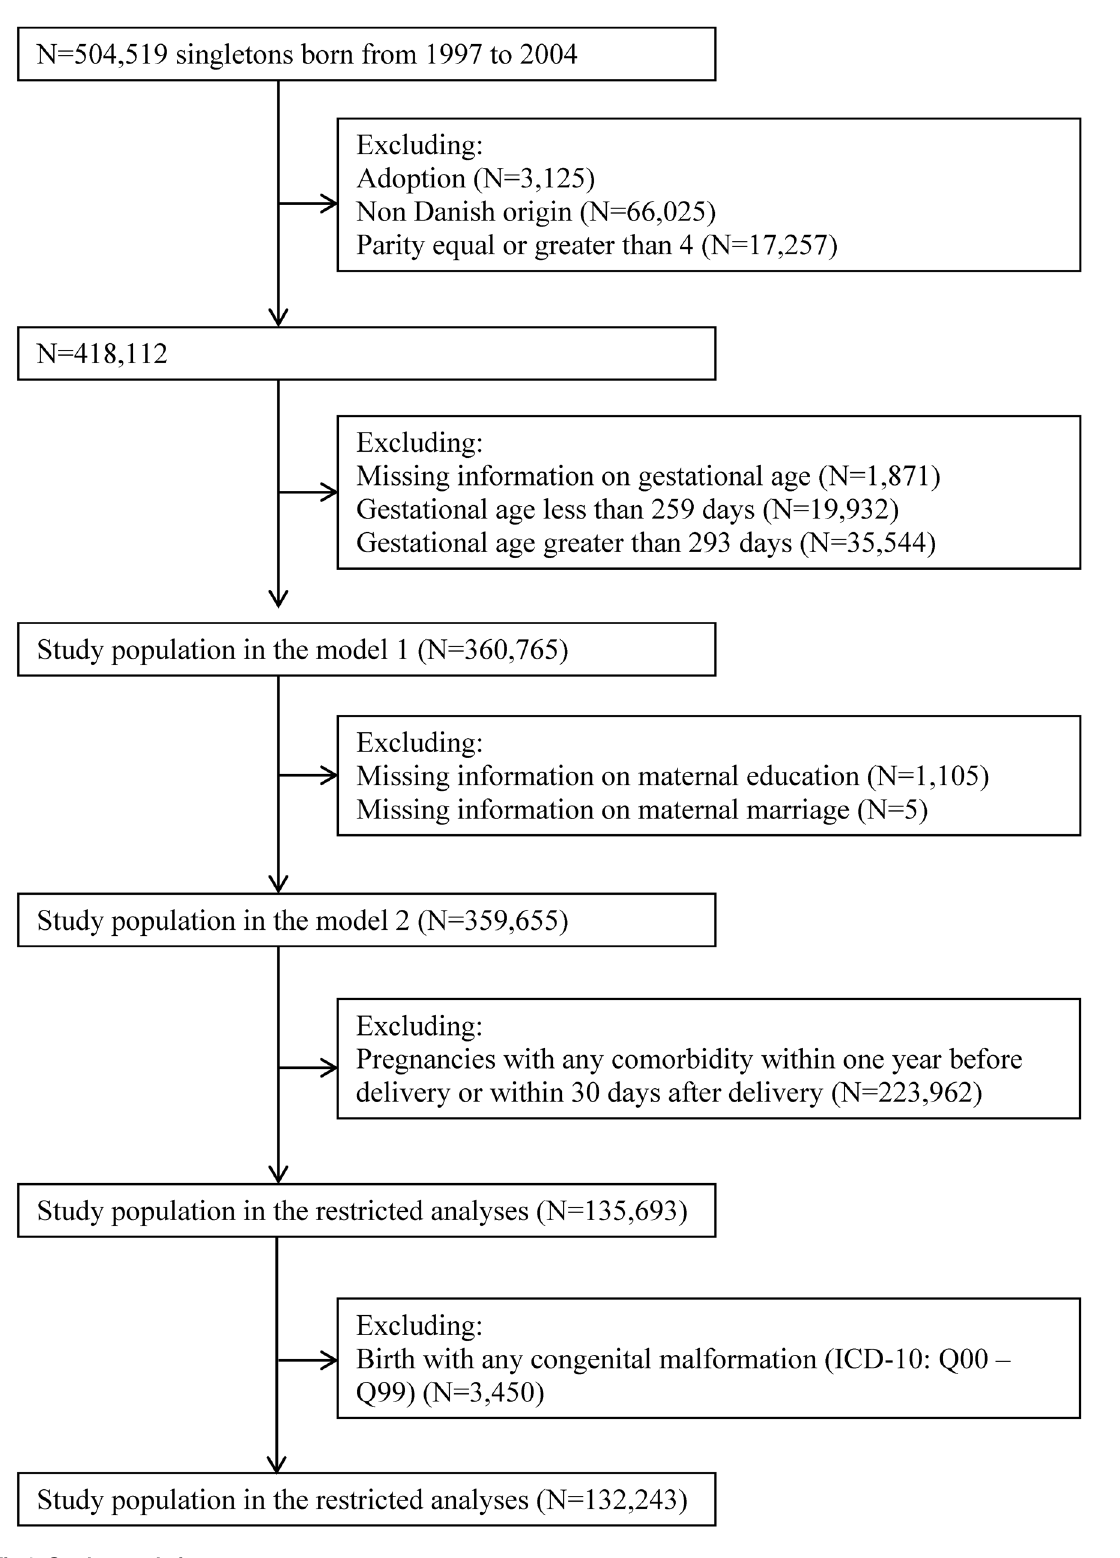
Fig 1. Study population.